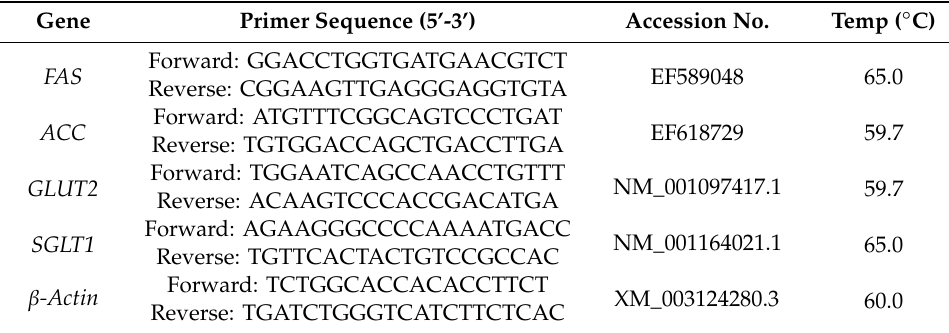
Table 2. Primer sequences of genes selected for analysis by real-time PCR. Gene Primer Sequence (5’-3’) Accession